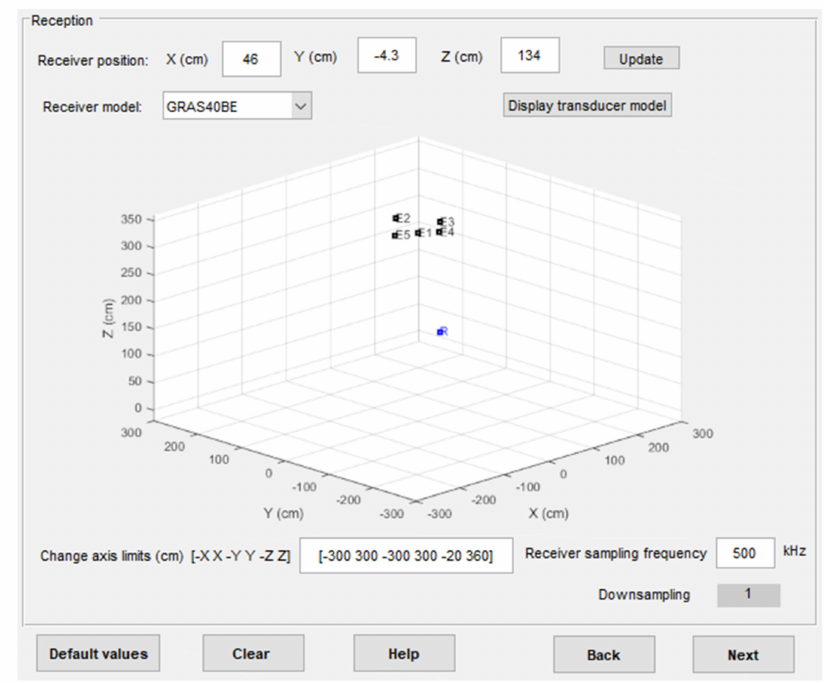
Figure 8. Example of a scene configuration in the simulator